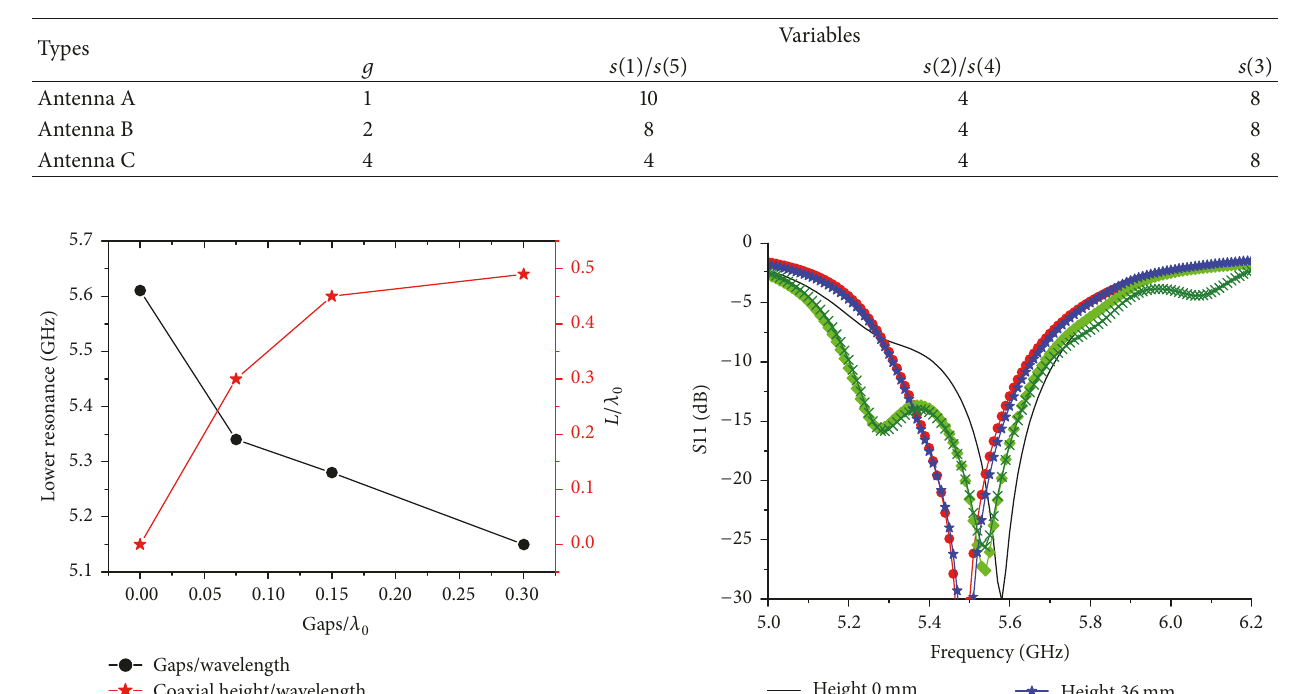
Table 1: Detailed dimensions of the different antennas (unit: mm).